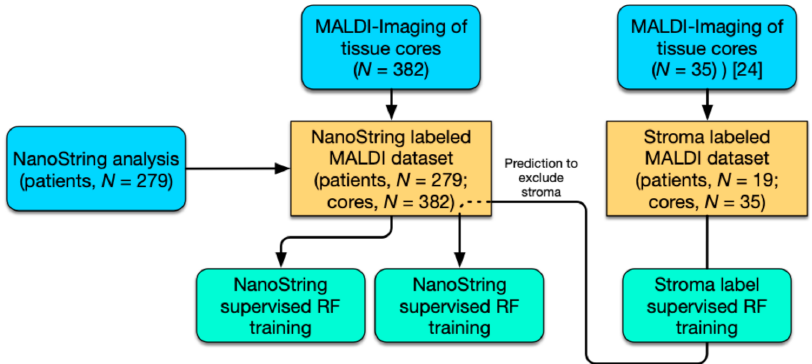
Figure 1. Workflow for the stratification of high-grade serous ovarian cancer (HGSOC) patients. Study workflow diagram of performed analysis (blue) including NanoString analysis (39 gene signature) and MALDI-Imaging; computational analysis by random forest (RF; aquamarine) and MALDI-Imaging datasets (yellow).